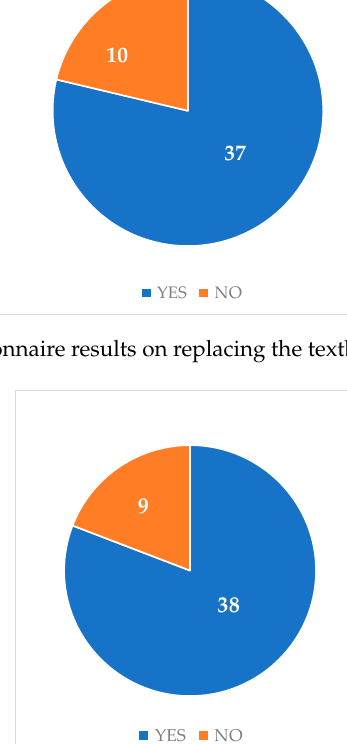
Figure 10. Questionnaire results on a multi-player setup for the game.